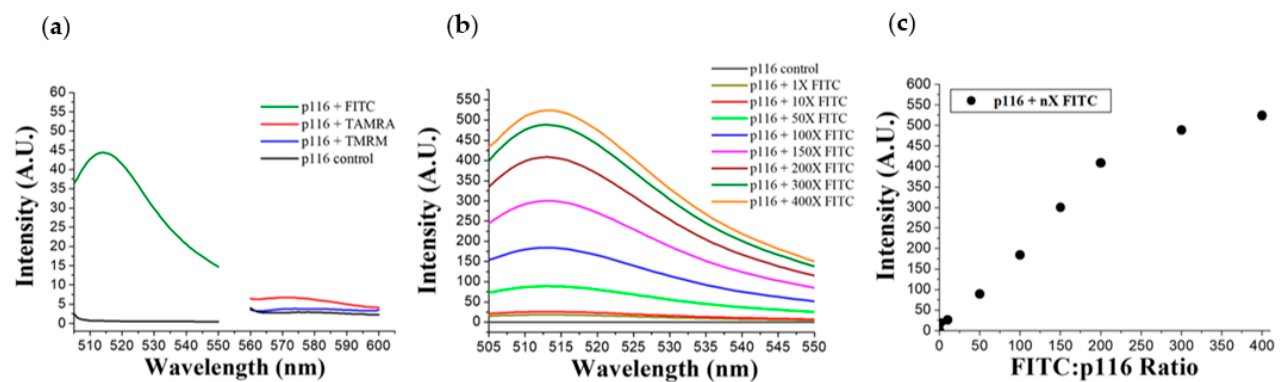
Figure 2. Fluorescence emission spectra of particles assembled by the RNA-binding domain 1 of HCV core protein (p116) in the presence of charged molecules. ( a ) Fluorescence spectra of p116-particles assembled in the presence of FITC, TAMRA, and TMRM; ( b ) fluorescence spectra of p116 interacted with different amounts of FITC. In ( a , b ), p116 control is the particles formed by p116 alone; ( c ) the fluorescence intensity at 513 nm of p116-assembled particles interacted with different molar ratios of FITC.